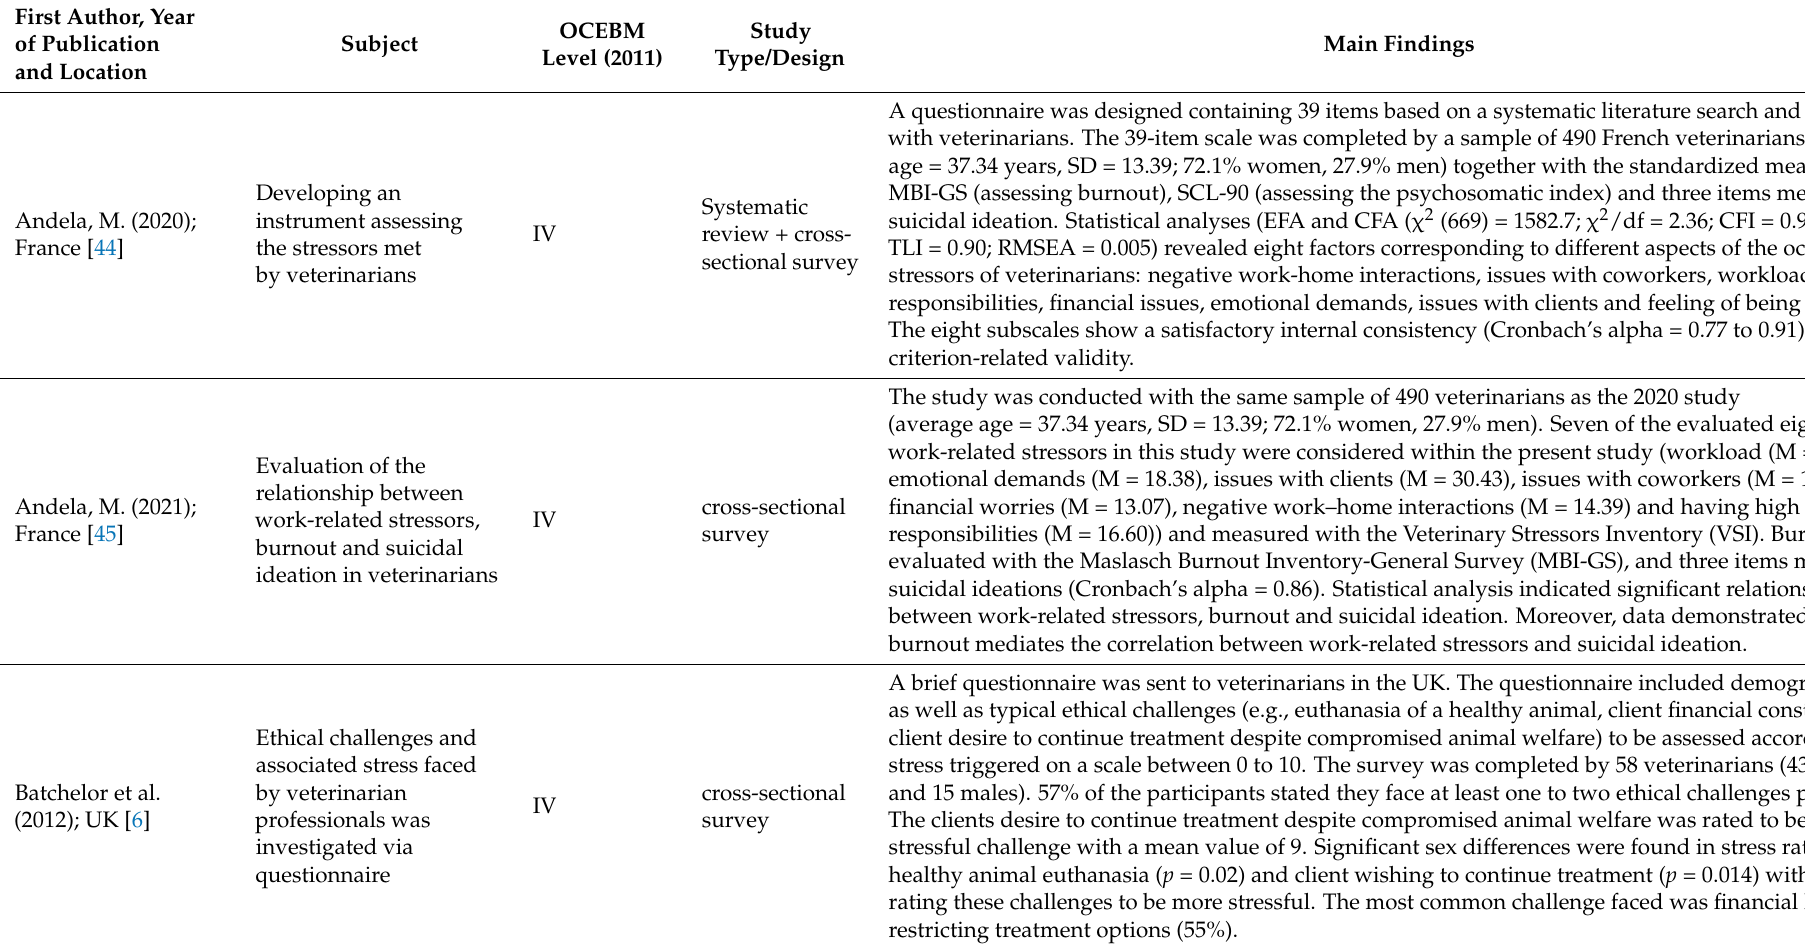
Table 3. Social and environmental